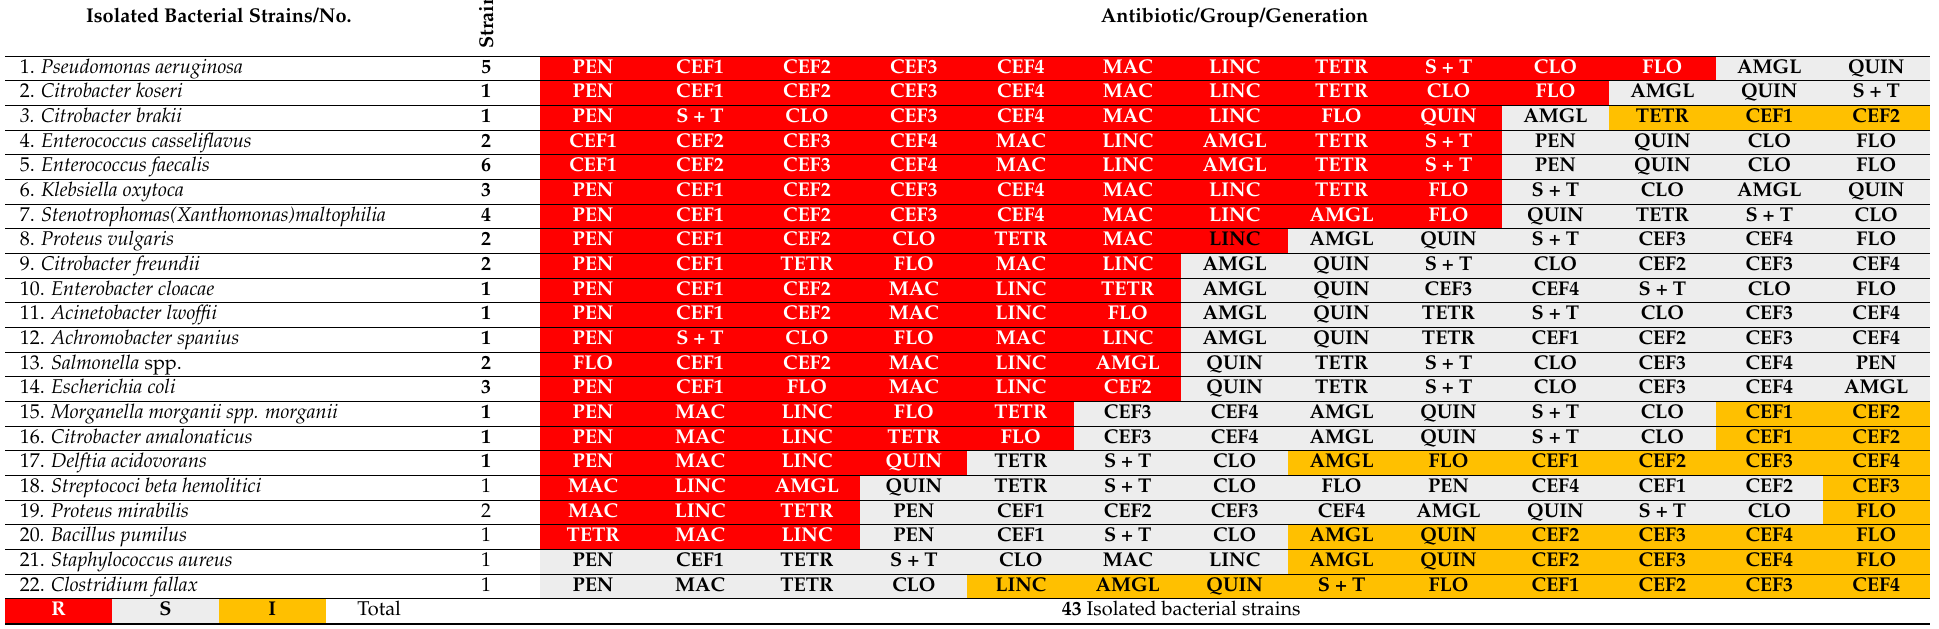
Table 2. Results of antibiogram/distribution of bacterial strains (susceptible/resistant/antibacterial) used. Isolated Bacterial